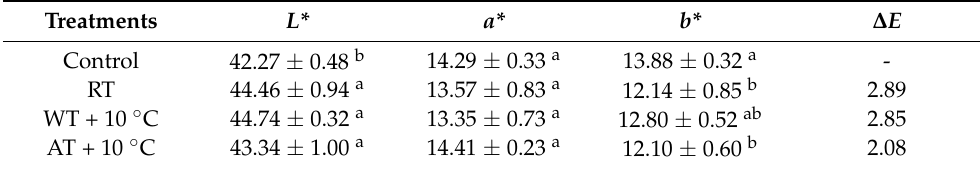
Table 4. Effects of different tempering methods on the color of salmon flesh. (RT: Radio frequency tempering; WT + 10 ◦ C: Water tempering at 10 ± 0.5 ◦ C; AT + 10 ◦ C: Air tempering at 10 ± 1 ◦ C; L* : lightness; a* : redness-greenness; b* : yellowness-blueness; ∆ E : the total color difference). Treatments L* a* b* ∆ E Control 42.27 ± 0.48 b 14.29 ± 0.33 a 13.88 ± 0.32 a - RT 44.46 ± 0.94 a 13.57 ± 0.83 a 12.14 ± 0.85 b 2.89 WT + 10 ◦ C 44.74 ± 0.32 a 13.35 ± 0.73 a 12.80 ± 0.52 ab 2.85 AT + 10 ◦ C 43.34 ± 1.00 a 14.41 ± 0.23 a 12.10 ± 0.60 b